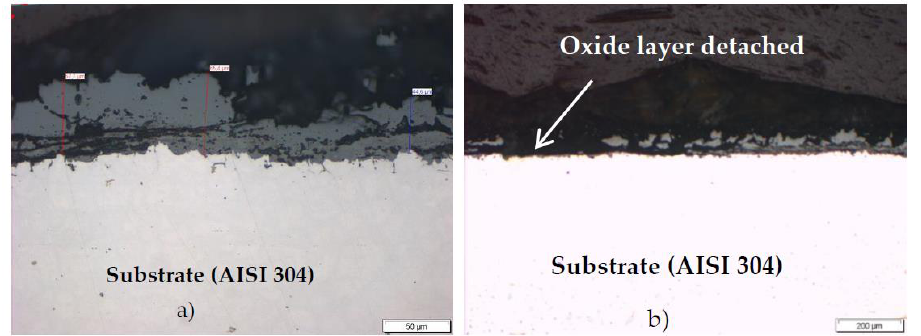
Figure 13. ( a ) Heterogenous thickness of the oxide layer in AISI 304 sample. ( b ) Lack of continuity; oxide layer detached in some areas.